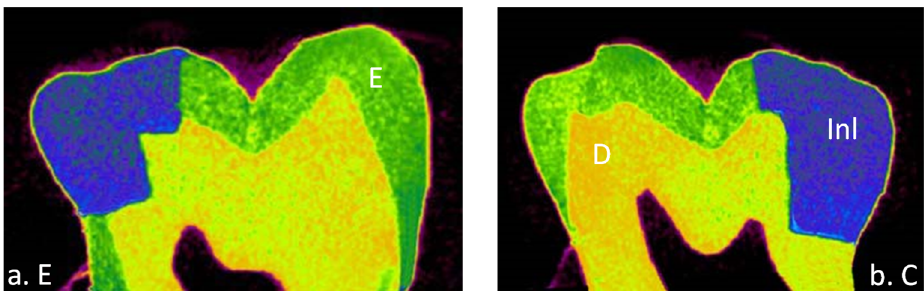
Superscript letters indicate homogenous subsets (within which p > 0.05) where comparison has been made with respect to resin cements at each enamel and dentin surface.